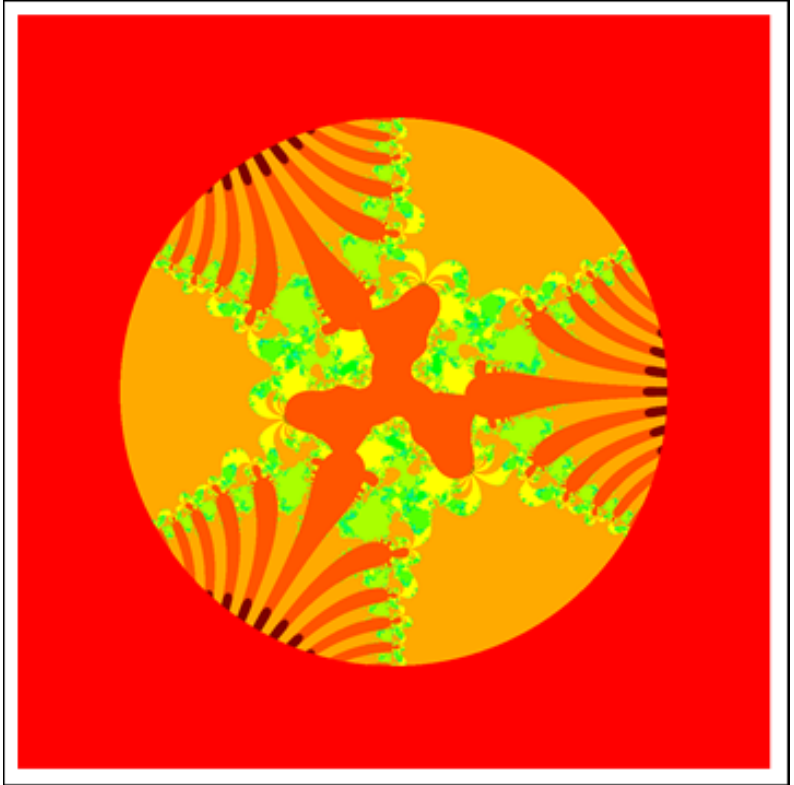
Figure 11. J-set for τ ( z ) = e z 3 + c via DKIS. The image execution time is 77.734